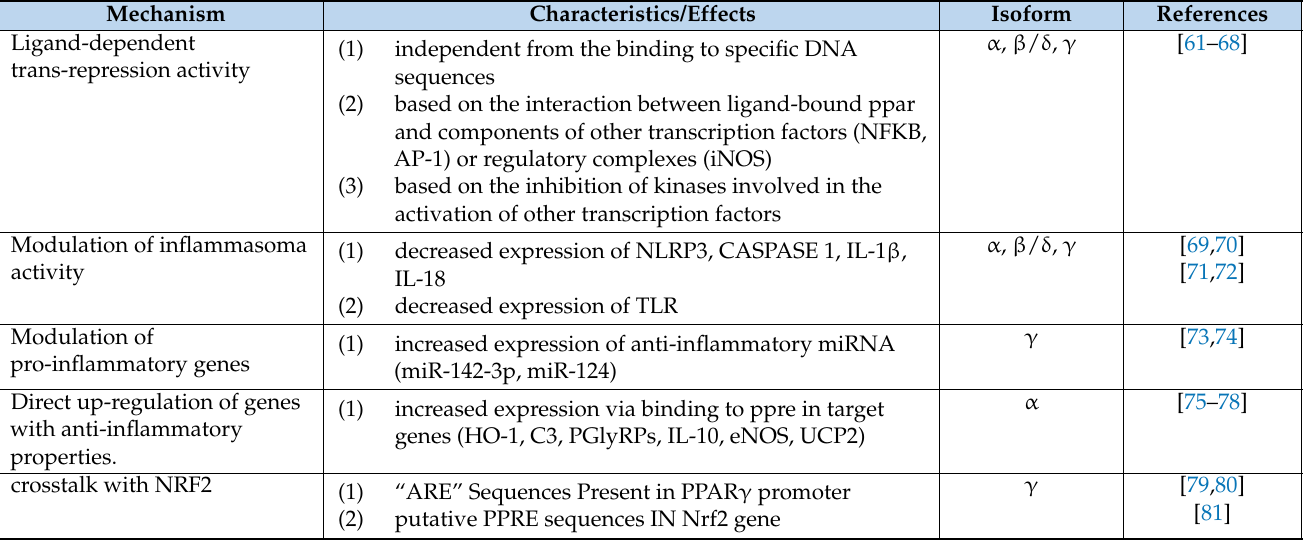
Table 2. Principal mechanisms responsible for the anti-inflammatory activity of